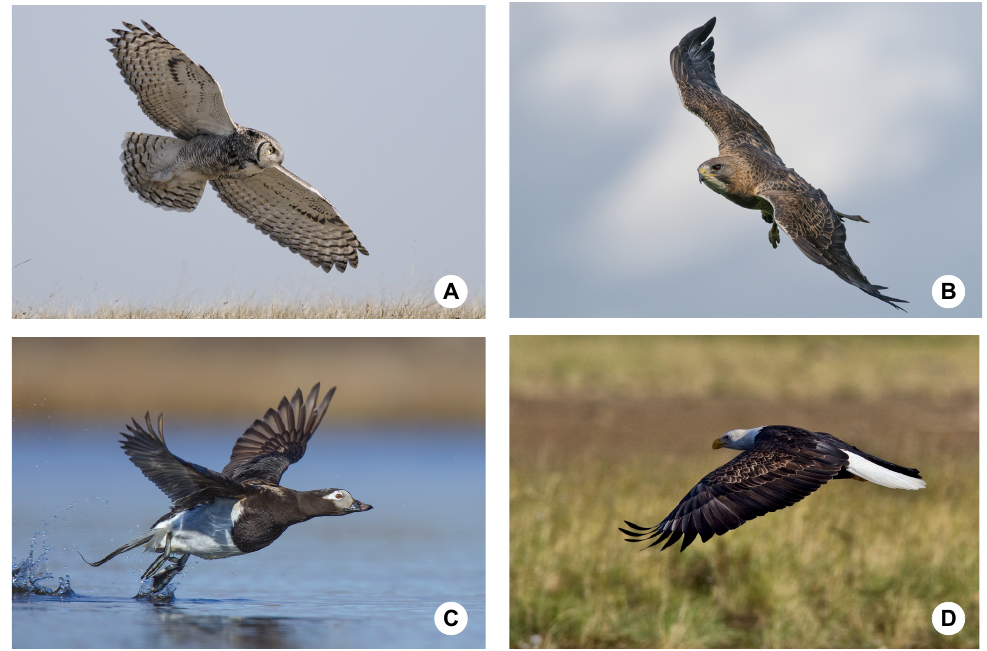
Figure 1. Birds’ wingtip feathers. ( A ) Great Horned Owl; ( B ) Swainson’s Hawk; ( C ) Long-Tailed Duck; ( D ) Bald Eagle. Images courtesy of Ad Wilson (www.naturespicsonline.com) and Rob McKay (http://robmckayphotography.com).